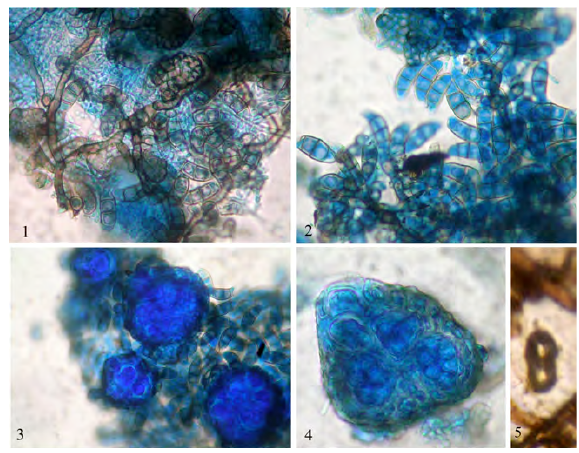
Image.19 Schiffnerula palodensis 1 - Colony with thyriothecia and Questieriella conidia; 2 - Questieriella conidia; 3 - Thyriothecia; 4 - Arrangement of asci in the thyriothecium; 5 - Ascospore